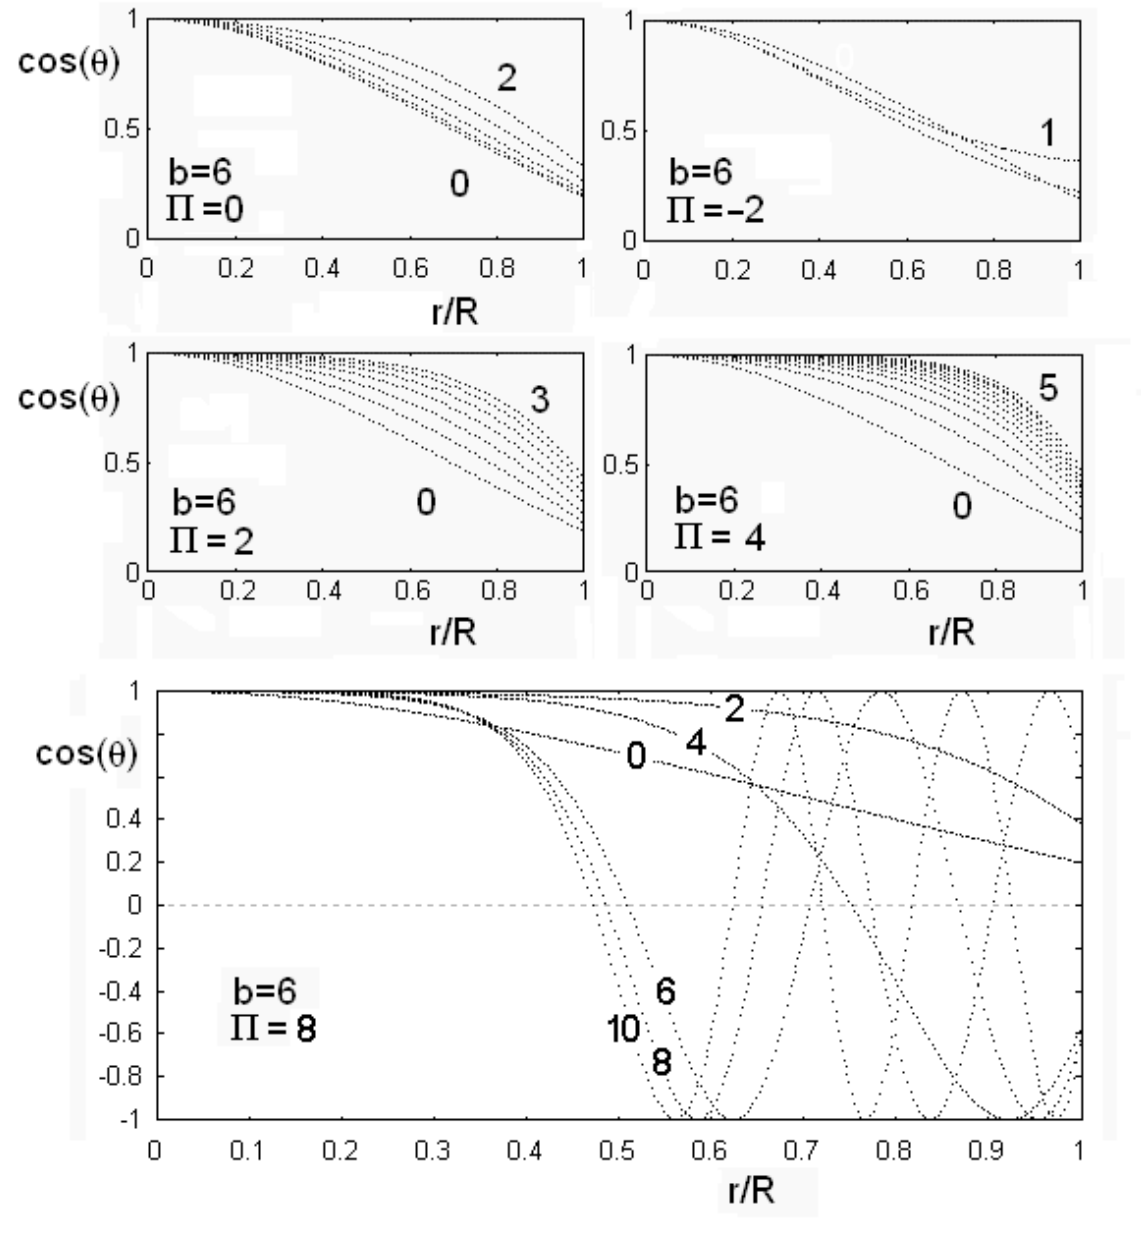
Figure 9. Behaviour of θ cos as a function of the reduced radial coordinate Rr , for different values of the flexoelectric coefficient Π and of the dimensionless electric field ) (some values of ξ are reported on the curves). The value of the anchoring strength is fixed in all the figures. Note that a negative value of the flexoelectric parameter is strongly favouring the alignment of director parallel to cylinder axis, and then the threshold electric field is very low. If the flexoelectric parameter is positive and large, the distorted configuration is favoured, and the threshold field, needed for suppressing this configuration, is increased. As shown in the lower part of the figure, when Π is very large, θ cos is oscillating as the electric field increases. A very large field is required to suppress the distortion and have 0 = θ